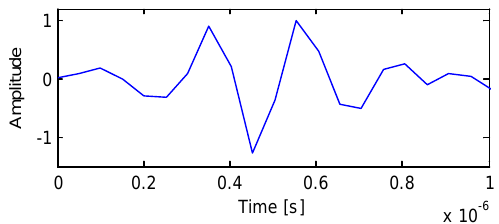
Figure 5. Diagram of the normalized deconvolution kernel in the experiment.